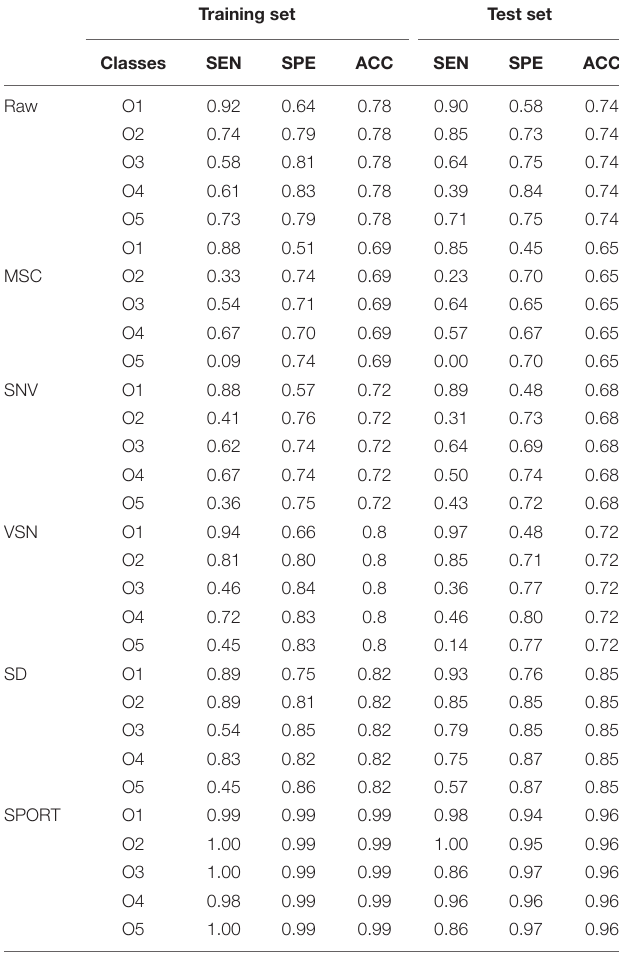
TABLE 2 | The classification parameters of PLS-DA